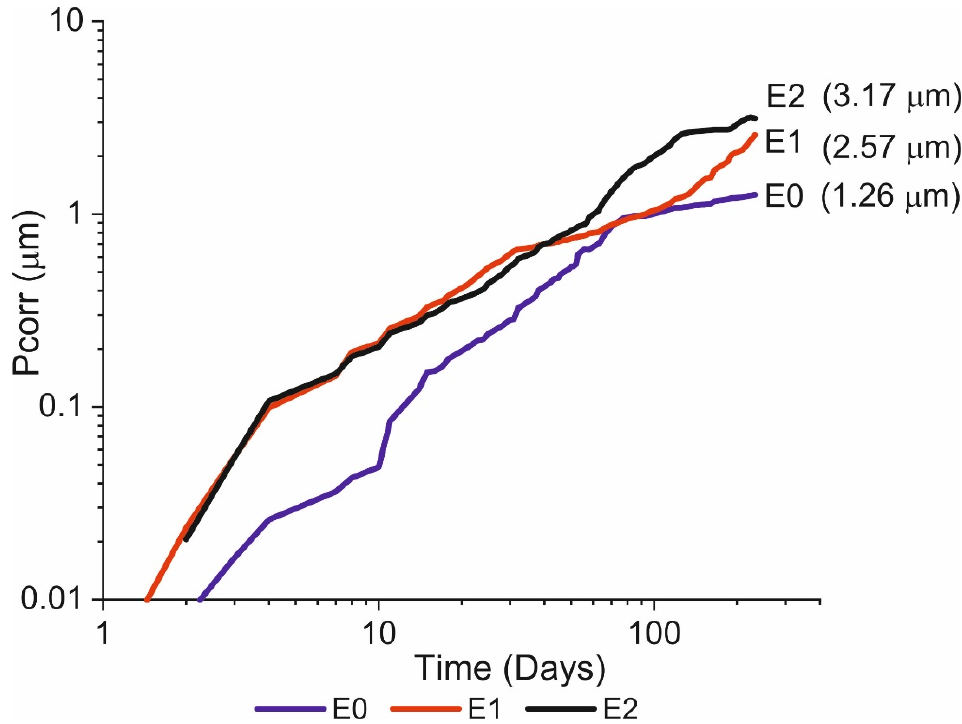
Figure 10. Cumulative section loss in specimens E0, E1, and E2, assuming uniform corrosion.